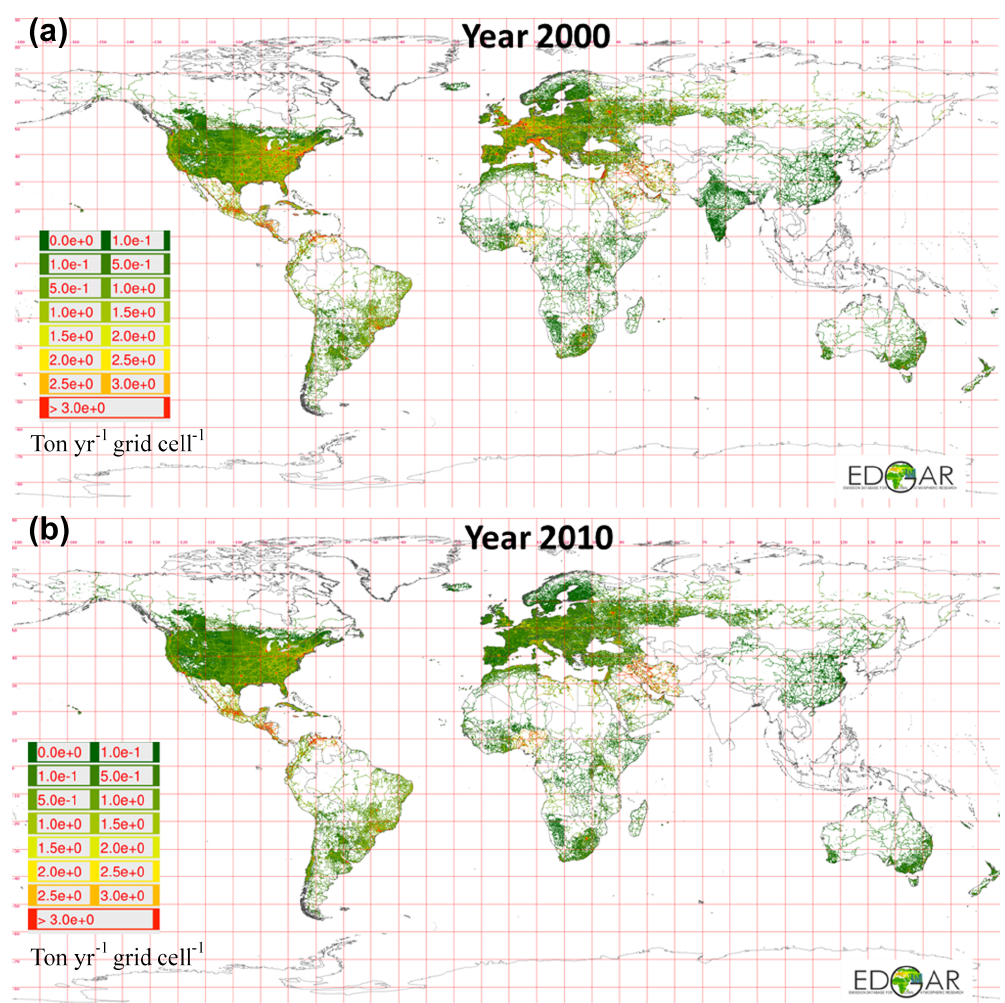
Figure 2. Comparison of 2000 and 2010 methanal emission grid maps for the road transport